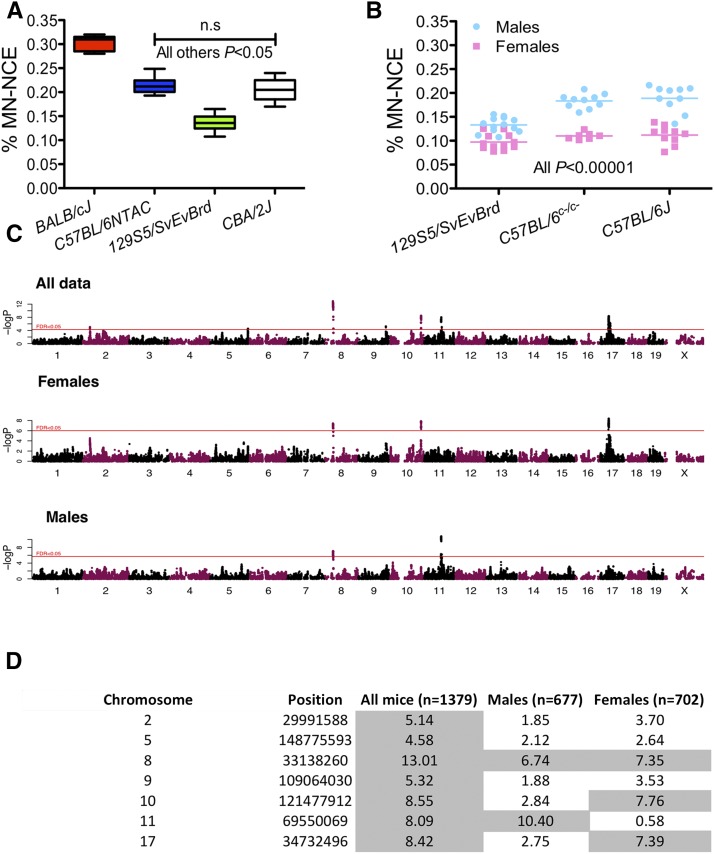
Micronucleus levels are genetically controlled. (A) Graph shows the percentage of micronucleated (MN) normochromatic erythrocytes (NCE) in males from four different inbred strains of mice. Boxplot shows the median and the min-max (whiskers) of at least six measurements for each strain. Data were analyzed by one-way ANOVA (P < 0.0001) followed by Tukey’s post hoc test (P < 0.05 for all combinations except C57BL/6NTAC and CBA/2J). (B) Micronucleus levels are influenced by sex in mice. Shown is the difference in micronucleus levels in males (blue) and females (pink) for three strains of inbred laboratory mice. Data were analyzed using the Student’s two-tailed t-test, P < 0.00001. (C) Manhattan plots of genome-wide analyses for micronucleus levels performed in all mice (top) or in female (middle) or male (bottom) mice only using the subset of tagging SNPs (n = 359,559). Horizontal red lines represent –log10 P-values at which QTL reach FDR < 5%. (D) QTL detected in all mice, males and females. Loci with FDR < 5% are shaded in gray. These QTL positions were defined using the above-mentioned 359,559 tagging SNPs. Shown are the maximum -log P values among tagging SNPs at each QTL.